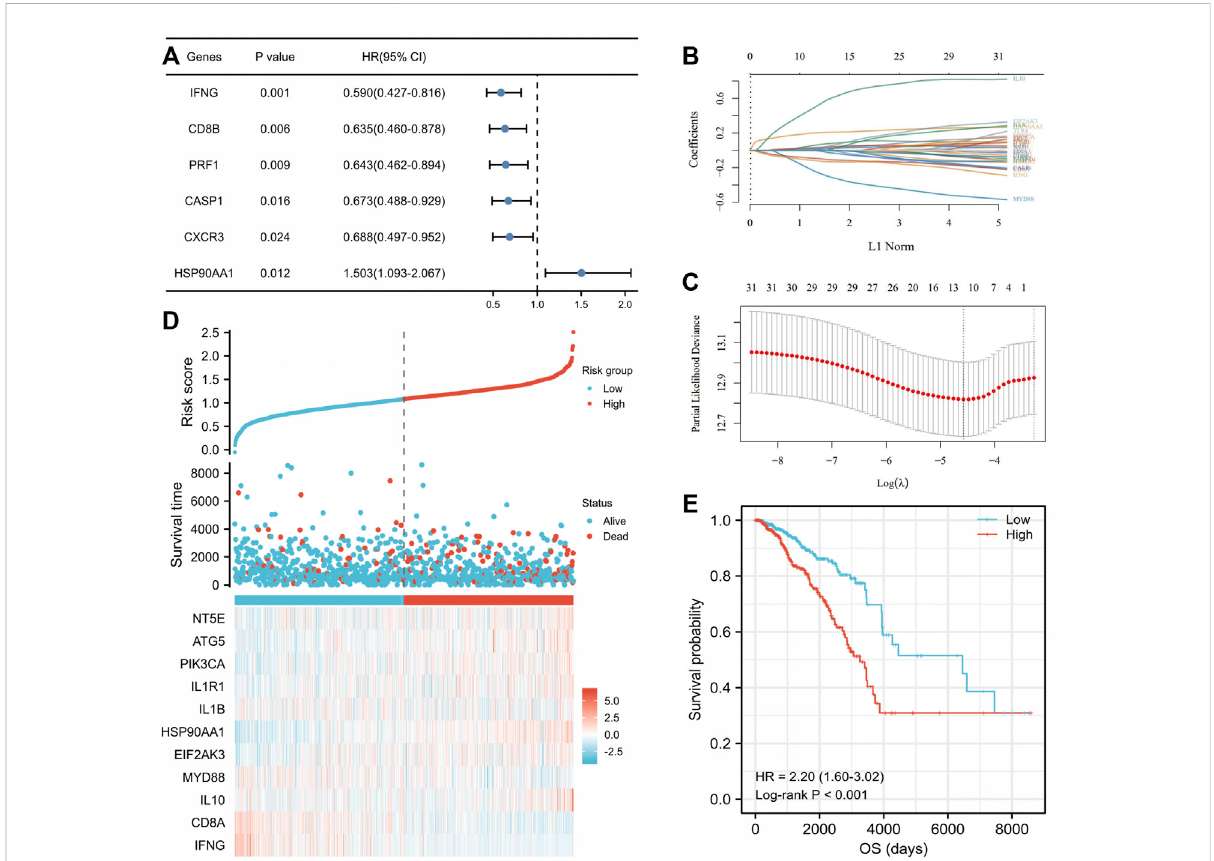
FIGURE 5 Construction of the immunogenic cell death (ICD)-related prognostic signatures in The Cancer Genome Atlas (TCGA) breast invasive cancer (BRCA)cohort. (A) UnivariateCoxanalysisexaminedtheprognosticabilityoftheICD-relatedgenesinoverallsurvival(OS)oftheTCGABRCAcohort. The coef fi cient of the 11 selectedgenes was displayed by the lambda parameter in whichthe abscissa represented thelambda value of independent variable and the ordinate represented the coef fi cient of the independent variable (B) . Eleven selected genes were with the lowest partial likelihooddevianceplottedusingtheLASSO-Coxregressionmodel (C) . (D) Distributionofriskscore,survivaltime,andstatusandheatmapof11ICD- related prognostic genes in the cohort. The top scatterplot with different colors represent the risk score from low to high in different groups.